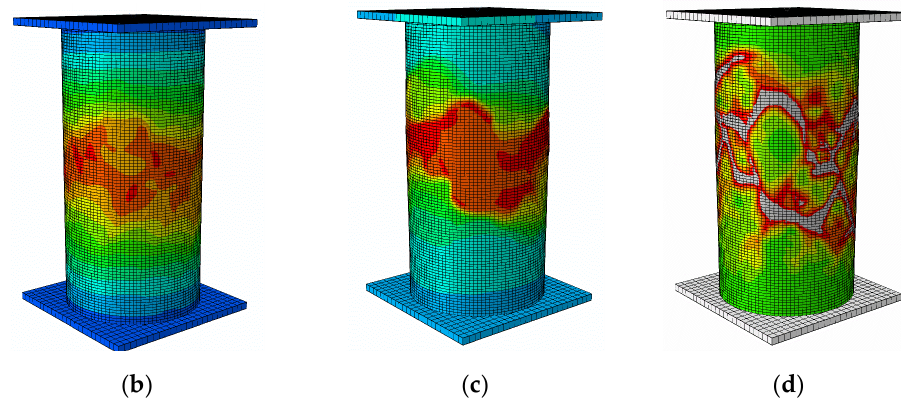
Figure 8. Field of radial displacement and stiffness damage in concrete specimen: ( a ) Ur at 1000 με; ( b ) Ur at 2000 με; ( c ) Ur at 4000 με; ( d ) SDEG at 2000 με.